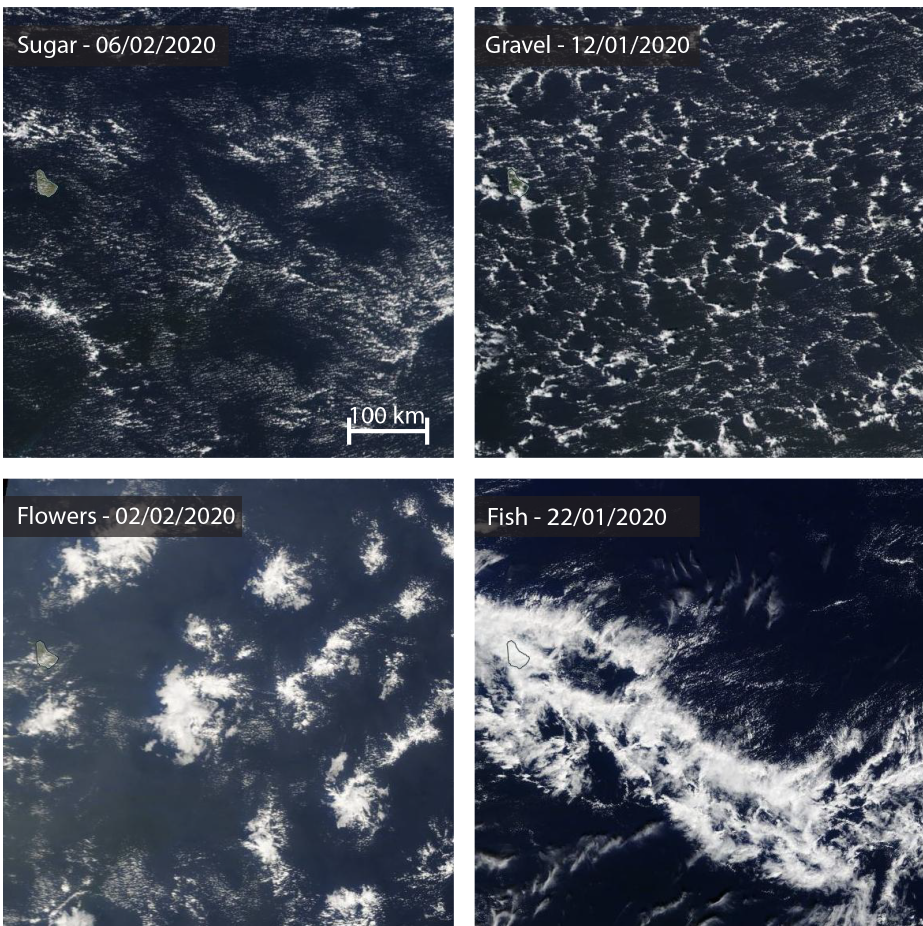
Figure 1. Four classes of mesoscale patterns of shallow convection have been labeled by 50 scientists in satellite images of January and February 2020. An example of each of these classes is shown based on the reflectance measurements of the Moderate Resolution Imaging Spectroradiometer (MODIS) on board the Terra satellite (sugar and gravel) and the Visible Infrared Imaging Radiometer Suite (VIIRS) on board the Suomi National Polar-orbiting Partnership (NPP) satellite (flowers and fish). Example images provided by NASA